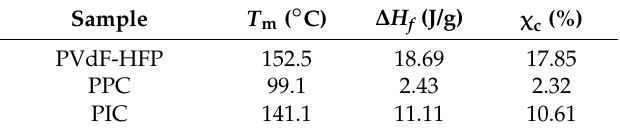
Figure 2. Typical SEM images of ( a , d ) PE separator; ( b , e ) PPC separator; ( c , f ) PIC separator. Table 1. DSC data of raw PVdF ‐ HFP materials and separators with different coatings.